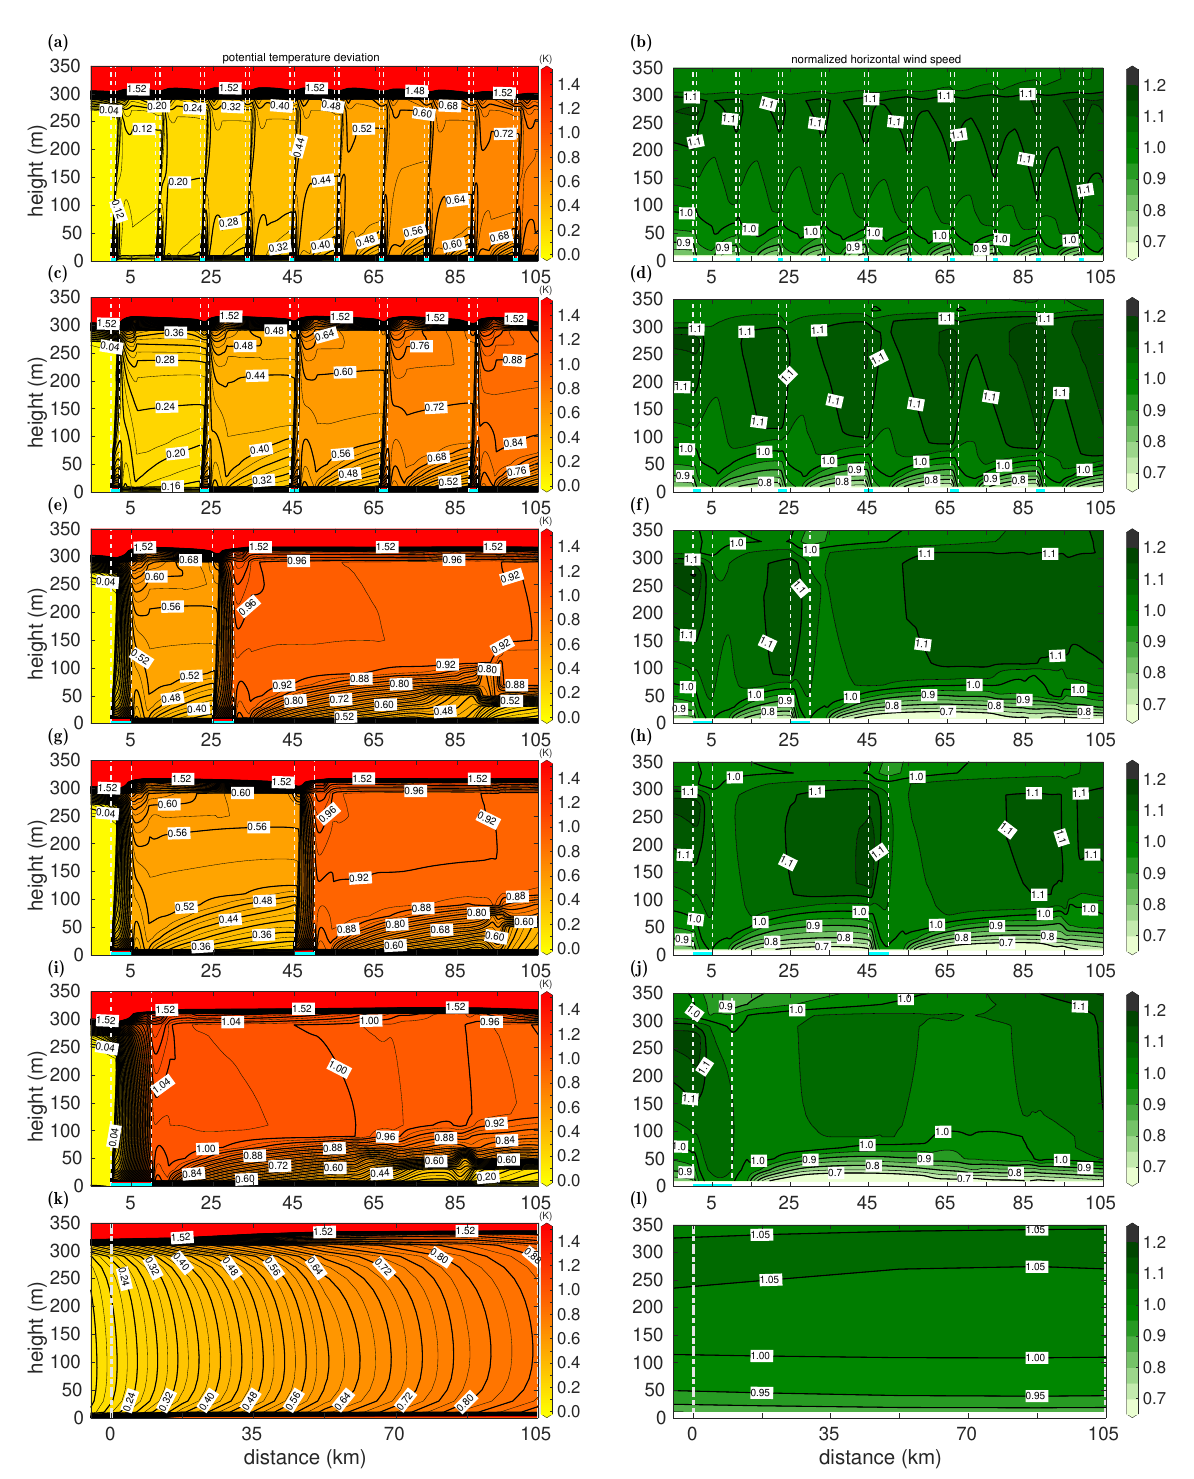
Figure 3. Deviation of potential temperature from the ABL-averaged inflow potential temperature (250K) and horizontal wind speed normalized by the ABL-averaged inflow wind speed (5ms − 1 ) as functions of height and distance to the downwind edge of the inflow region at 0km obtained by the model runs NL-M20-zi of the lead-resolving cases (ENS-1km ( a , b ), ENS-2km ( c , d ), ENS-5km-d20km ( e , f ), ENS-5km-d40km ( g , h ), and ENS-10km ( i , j )), and by the model run NL-LS96-zi for case ENS-C ( k , l ). Cases and model runs are described in Figure 2 and Table 1 (see Section 2). Dashed white lines denote the positions of the leads (also marked by the blue rectangles) in the first five cases and the boundaries of the model domain in case ENS-C. The flow is from left to